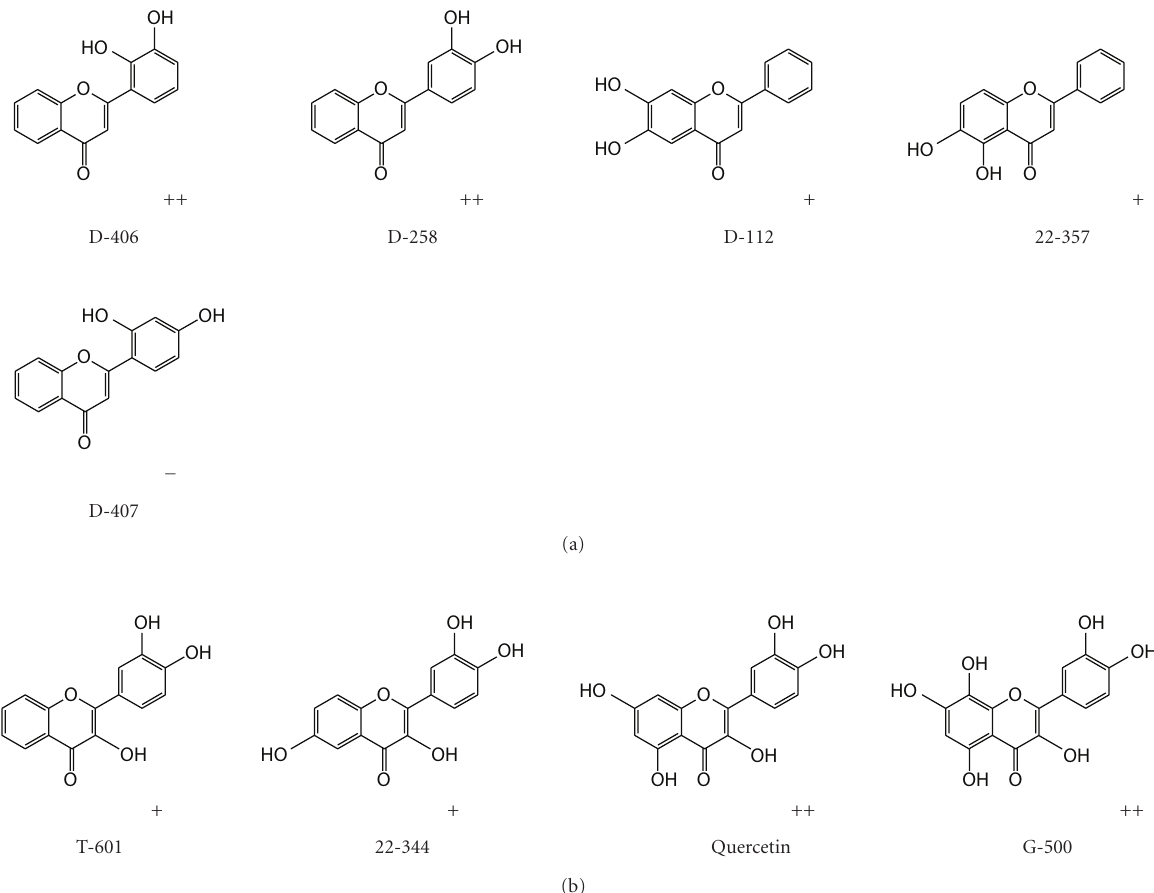
Figure 11: Structural comparisons among the 5 flavones with two hydroxyl groups (a). Structural comparisons among the 4 flavonols with di ff erent numbers of individual hydroxyl groups or dihydroxyl groups